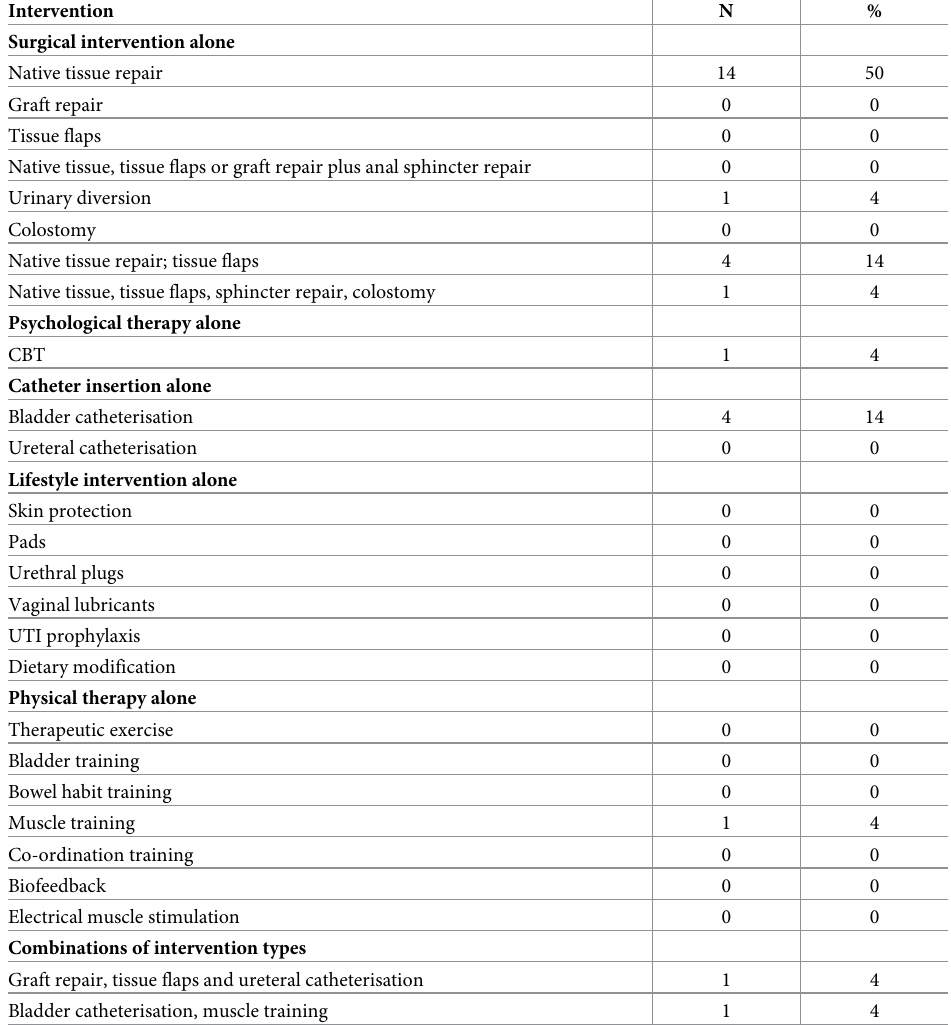
Table 5. Interventions assessed by included studies (N =